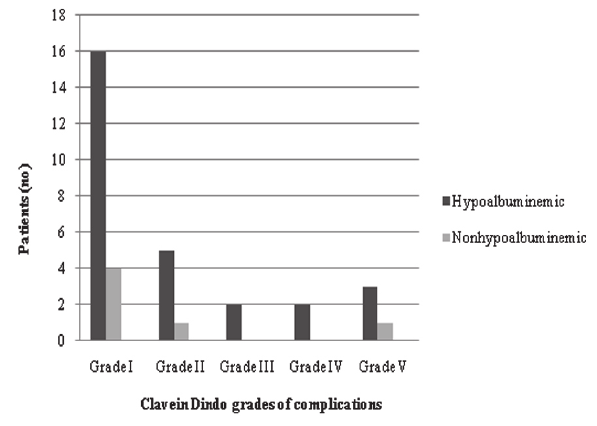
Figure 2: Albumin level and Clavien Dindo Grades of complication